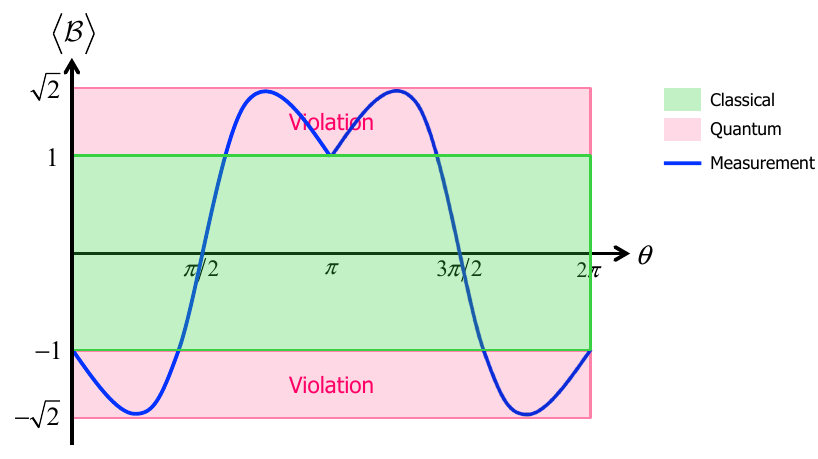
Figure 1. The result of the Bell